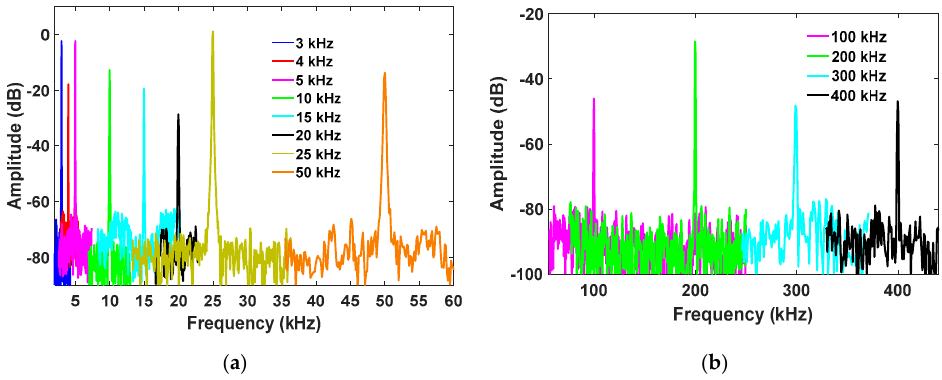
Figure 5. Measured frequency spectra for ( a ) 3 kHz to 50 kHz and ( b ) 100 kHz to 400 kHz.